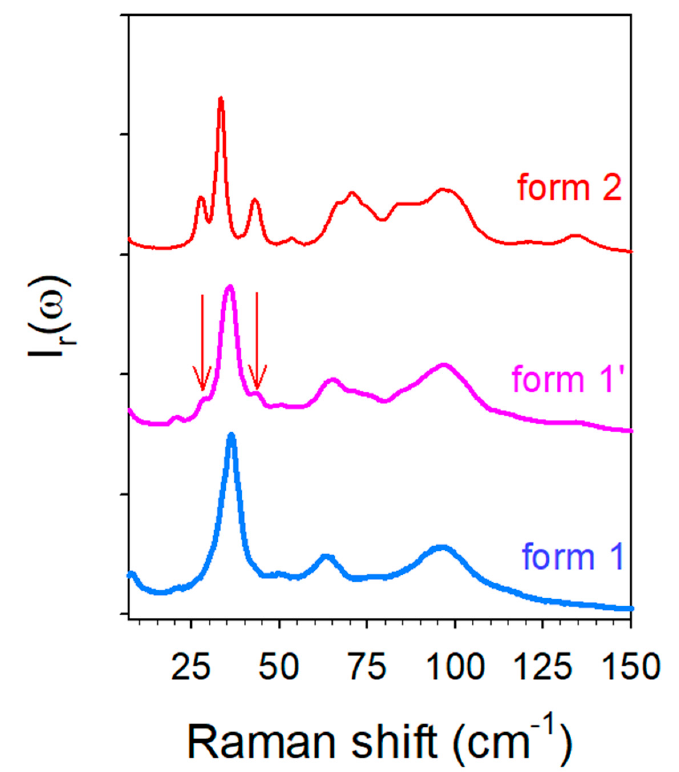
Figure 11. Low-frequency spectra of pseudo polymorphic forms of TP-CA co-crystals at room tem-